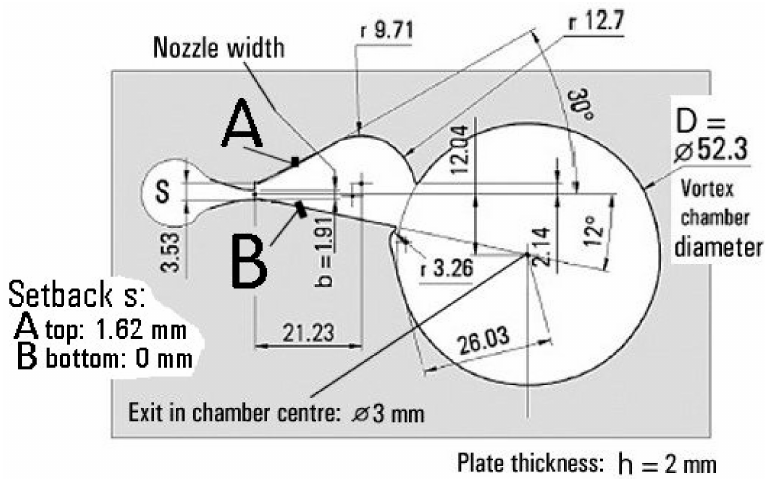
Figure 11. Workshop drawing of the plate with the final cavities. Note the di ff erent setbacks A and B compared to Figure 10 above. The geometry of cavities was developed from those of the amplifier discussed in